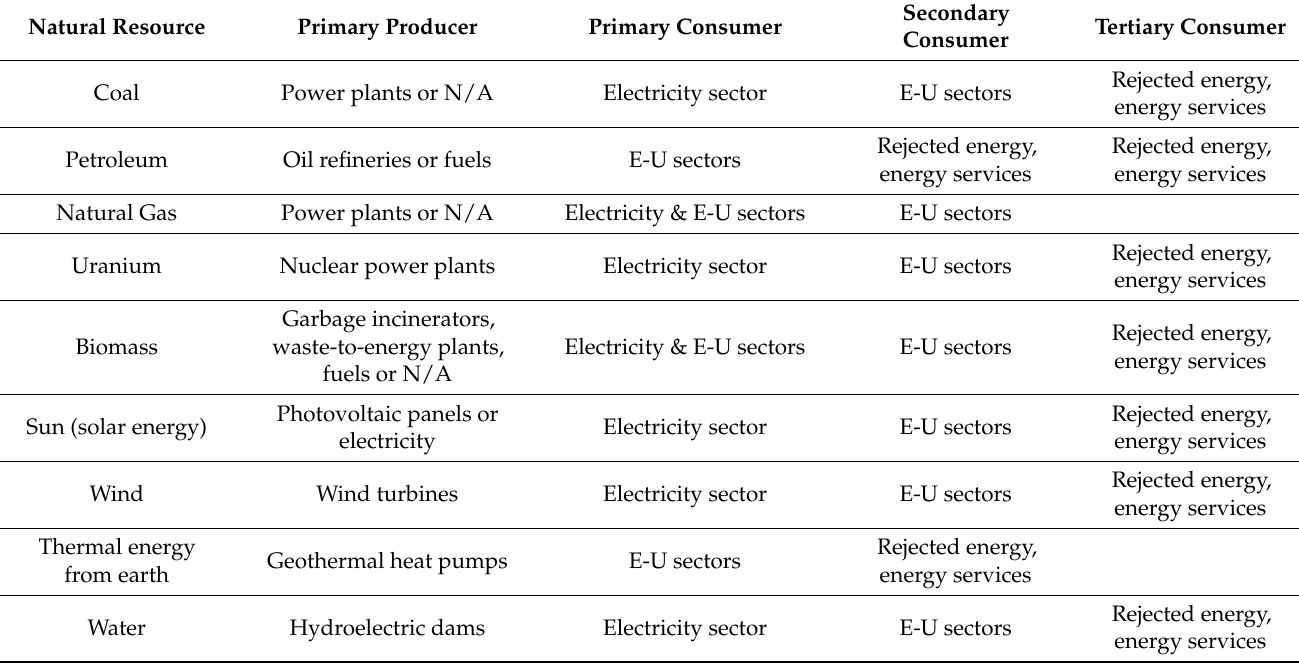
Table 1. The trophic levels of Maryland’s energy industry. This table is intended to be read from left to right for each row. End-use (E-U) sectors can be found in both primary and secondary consumer levels because all consume considerable amounts of primary producers’ energy relative to electricity sector energy, making them primary consumers in some circumstances. However, the energy E-U sectors consume from the electricity sector is still substantial in all cases besides the transportation sector which almost entirely consumes petroleum directly, making three E-U sectors also secondary